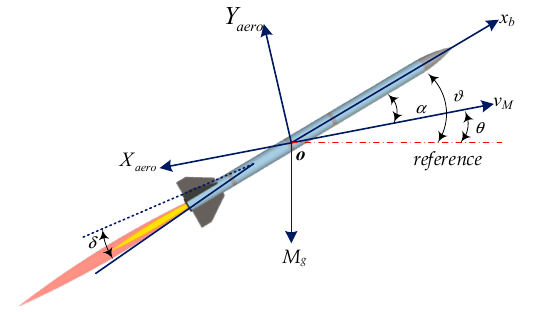
Figure 2. Guidance geometry. As can be seen in Figure 2, which gives the pursuit geometry of the missile–target in the pitch plane, R denotes the relative distance between the missile and the target. ˆ ˆˆ Pxy θ and v , a denotes the velocity, the flight denotes the inertial coordinate system. T T T θ and v , a rep- path angle, and the acceleration of the target, respectively. Similarly, m m m resent the velocity, the flight path angle, and the acceleration of the missile, respectively. x y and , x y denote the position of the missile and target. q is the LOS angle. , m m T T O x is the missile body axis, and ϑ is the pitch angle of the missile. m b